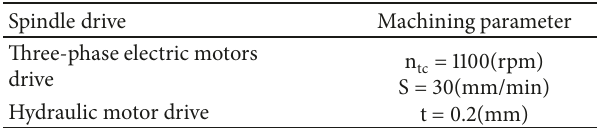
Table 7: Machining parameters